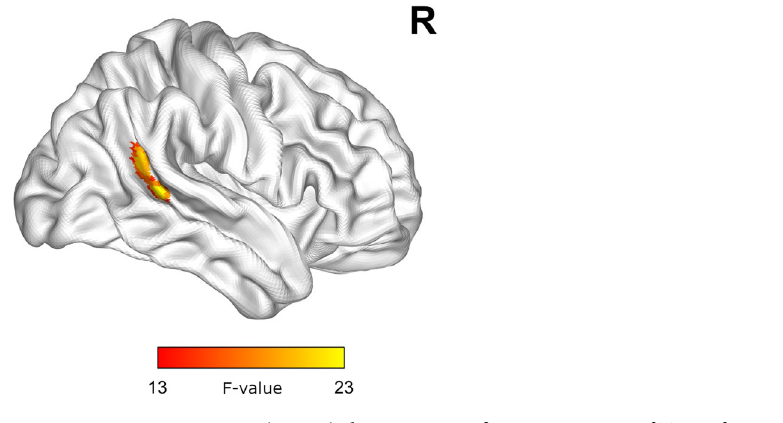
Figure 5. Brain activations (F-map) showing a significant interaction of Type of Comments × Story effect. Thresholded for voxel-level at p < 0.001 and FWE-corrected p < 0.05 for cluster size.